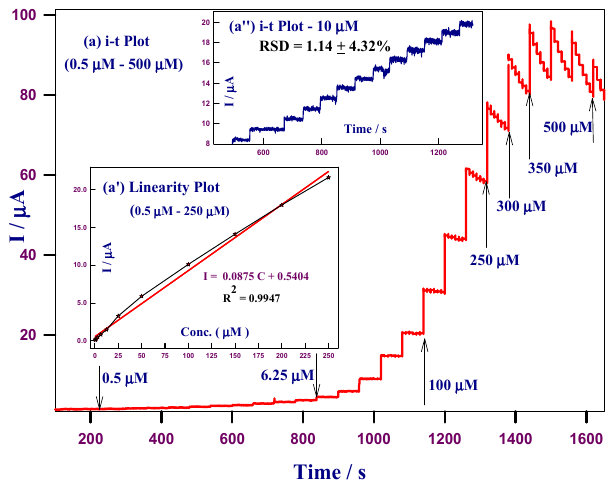
Figure 8. Amperometric i–t curve of a HCNiO/GC electrode in different concentrations of glucose in 0.05 M NaOH at E = 0.52 V; ( a ) i–t plot of 0.5 µM to 500 µM glucose; inset ( a’ ) linearity plot of 0.5 µM to 250 µM glucose; and inset ( a” ) i–t plot of 10 µM glucose for Relative standard deviation (RSD).